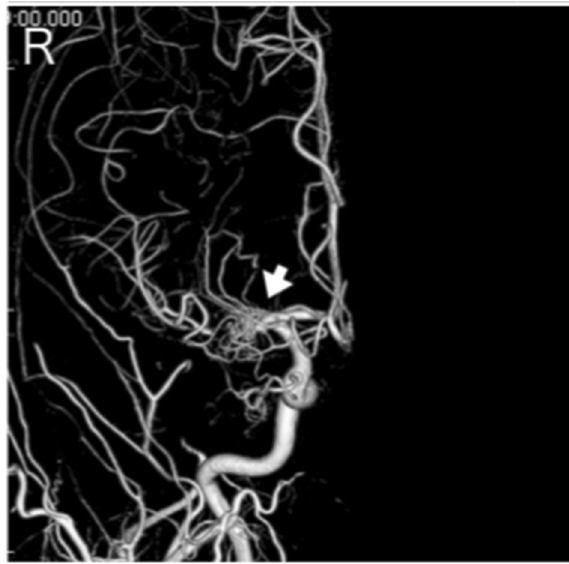
Figure 4. Anterior posterior view of three-dimensional digital subtraction right internal carotid angiographical findings in patient 4 indicating right twig-like middle cerebral artery. There was no stenotic area and moyamoya vessels in the terminal portion of the internal carotid artery (white arrow). These imaging findings did not indicate moyamoya disease.